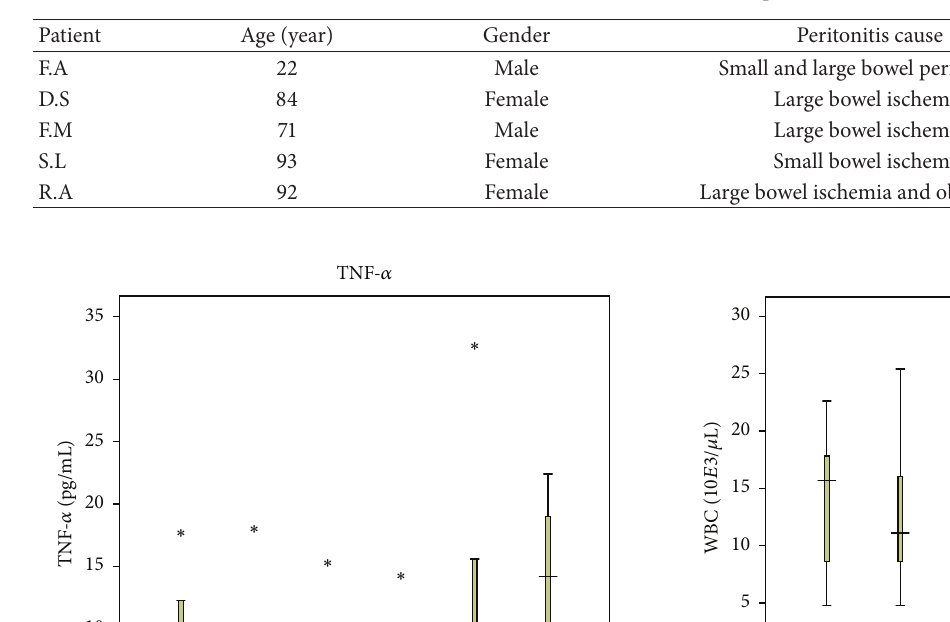
Table 2: Clinical features of the patients.